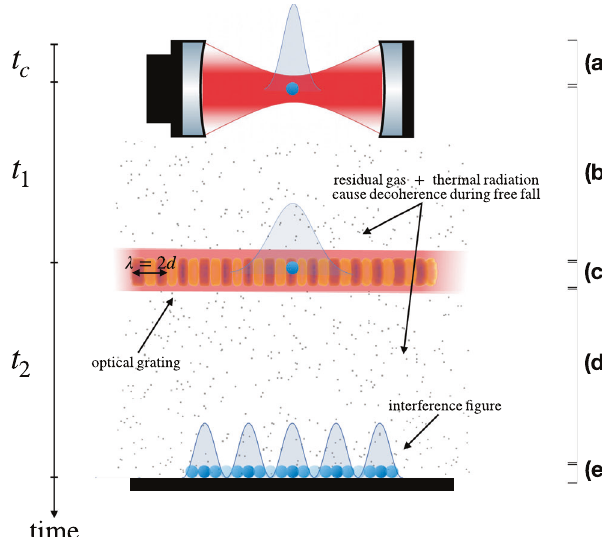
Fig. 4 Schematic representation of a near- fi eld interferometry experiment. The fi gure sketches the different stages of a near- fi eld interferometry experiment employing single nanoparticles, as described in the Near- fi eld interferometry subsection. The letters ( a – e ) correspond to the different steps as described in the main text. a The particle is initially trapped in an optical cavity for a time t c ; ( b ) The particle evolves freely for a time t 1 subject to the decoherence effects of its environment; ( c ) The particle interacts with a laser standing wave with wavelength λ resulting in a laser grating with a period d = λ /2; ( d ) The particle evolves freely for a time t 2 ; ( e ) The position of the particle is fi nally recorded. Note that while for ground-based experiments the time axis corresponds also with the vertical position of the particle, in space-based experiments the particle remains in the same position (relative to the experimental apparatus) and the trapping laser, the grating laser, and a fi nal measurement laser must be activated in turns at different